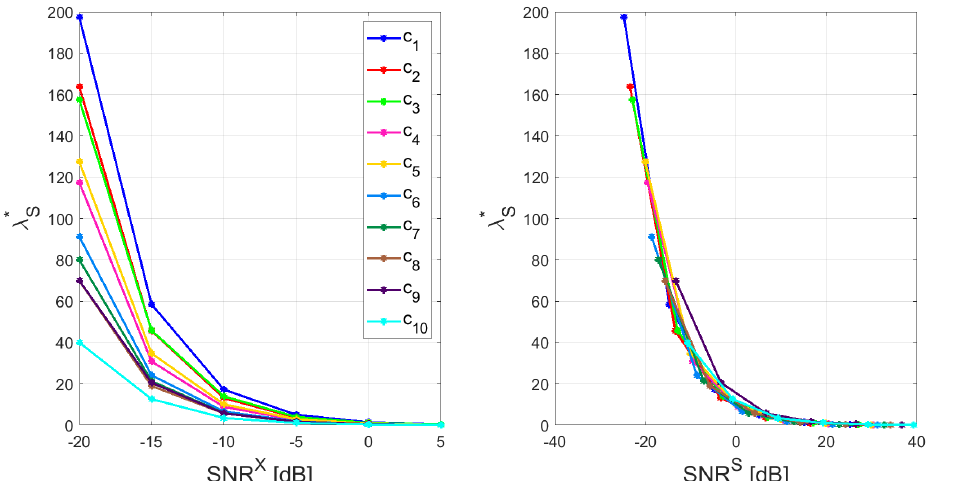
Figure 4. Optimal regularization parameters for the reconstruction of the cross–power spectrum ( λ ∗ ) as a function of SNR X ( left ) and SNR S ( right ). Different colors correspond to different MVAR S models. On the left, the lines have different heights, while on the right they overlap, meaning that the dependence of λ ∗ on SNR S is neater with respect to SNR X S